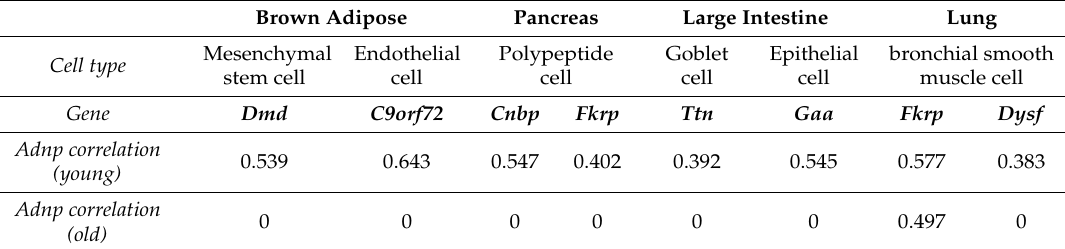
Table 1. Adnp correlates with muscle disease gene transcripts at the single-cell level. Cosine similarity values for the genes of interest (see Gene) and Adnp in young (3 months) and aged (18 and 24 months) mouse tissue and cell types at the single-cell level, showing an overall loss of correlation with Adnp with aging.